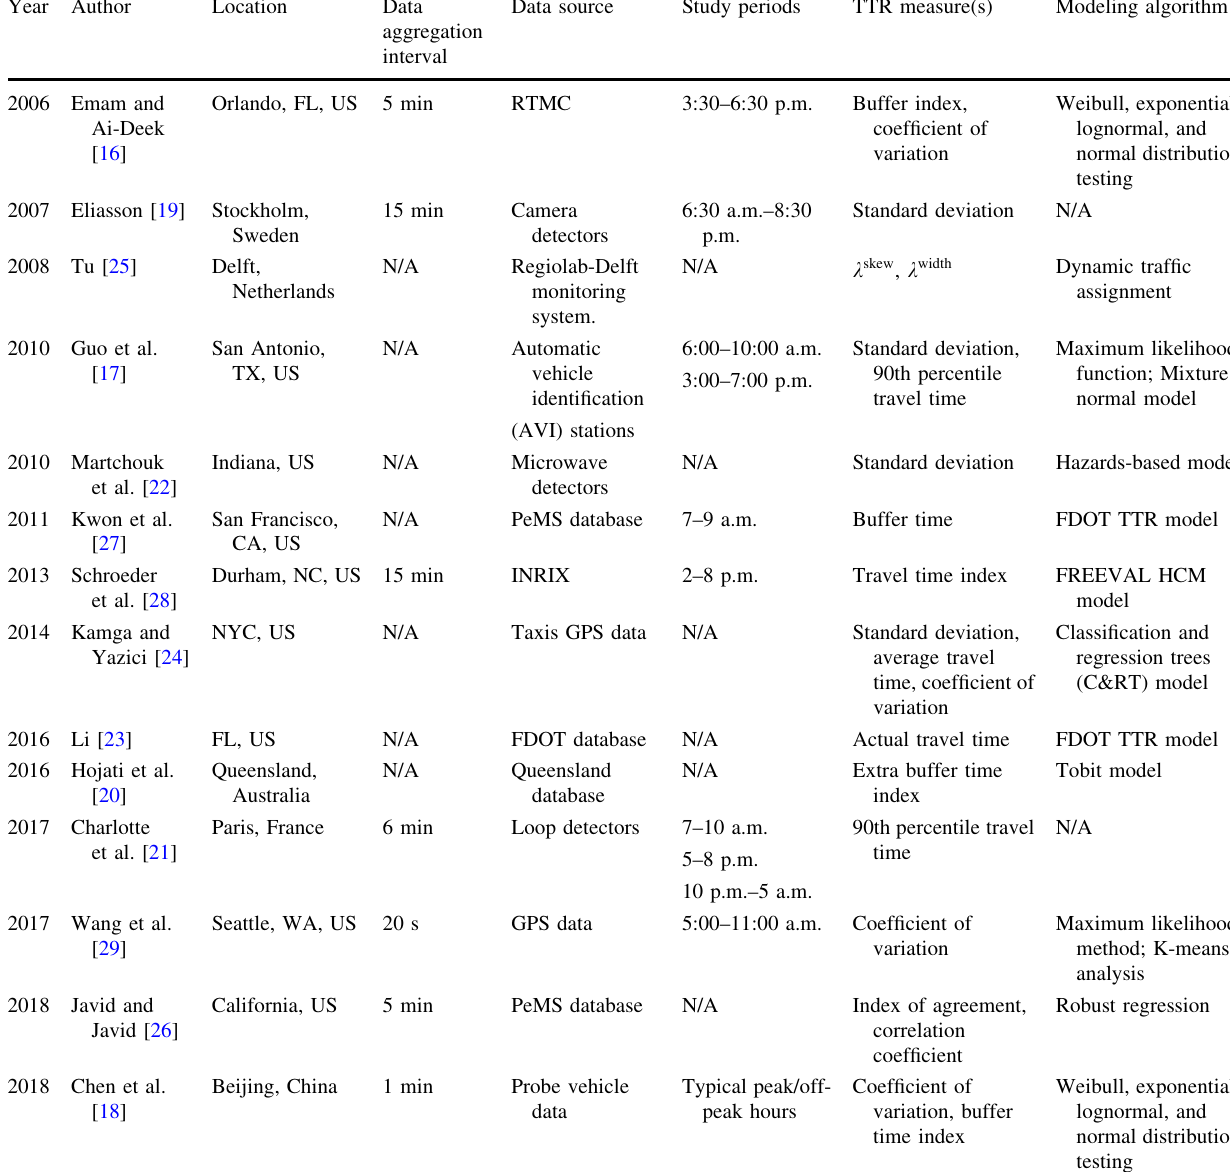
Table 3 Summary of previous studies on TTR analysis and modeling Year